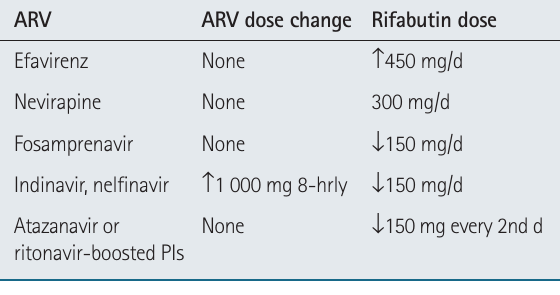
tAble Viii. shARed side-effects of tb